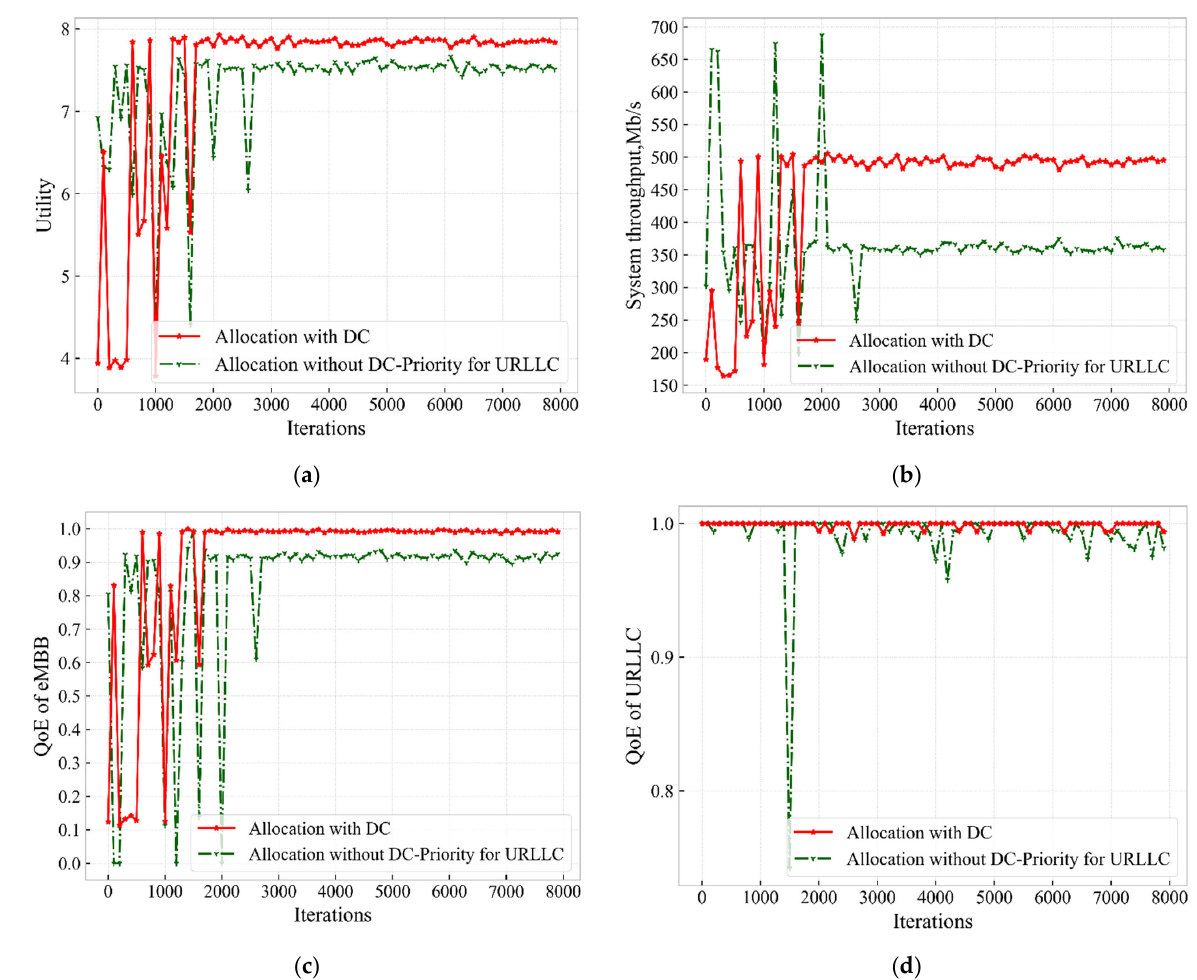
Figure 9. The comparison of optimization goals under the LSTM ‐ D3QN algorithm with and without dual connectivity assistance while there is priority for URLLC service. ( a ) The comparison of utility; ( b ) the comparison of system throughput; ( c ) the comparison of QoE of eMBB; ( d ) the comparison of QoE of URLLC.